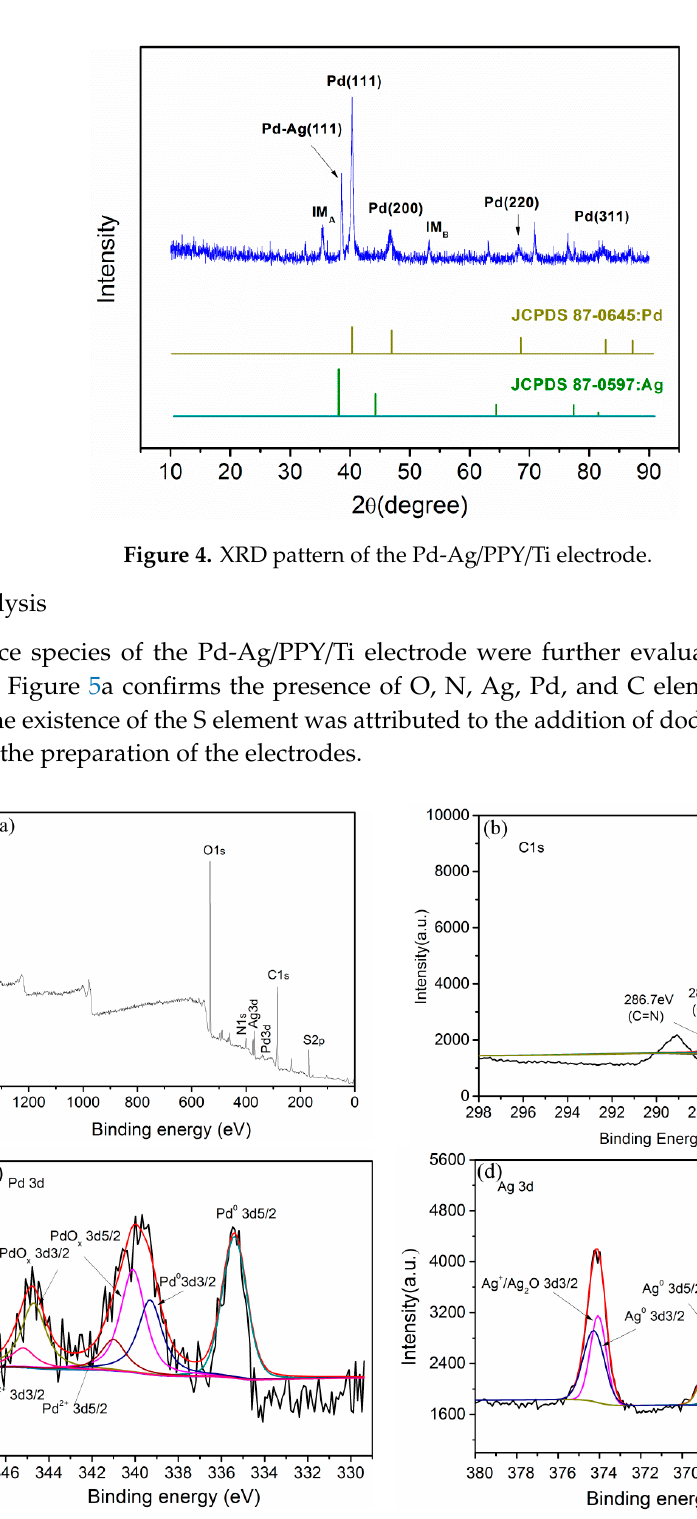
Figure 5. XPS of ( a ) full spectrum, ( b ) C 1s, ( c ) Pd 3d, and ( d ) Ag 3d of the Pd–Ag/PPY/Ti electrode.